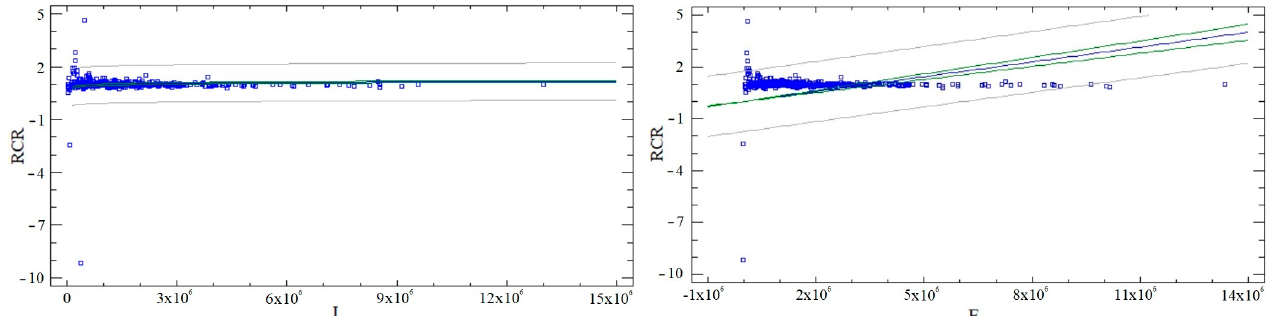
Figure 5. Illustration of the dependence of the RCR index on incomes and expenditures in 2004 (cooperatives). Table 3 . Regression functions of the relationship of the RCR index with income/expenditure in the years 2004–2019 (cooperatives).